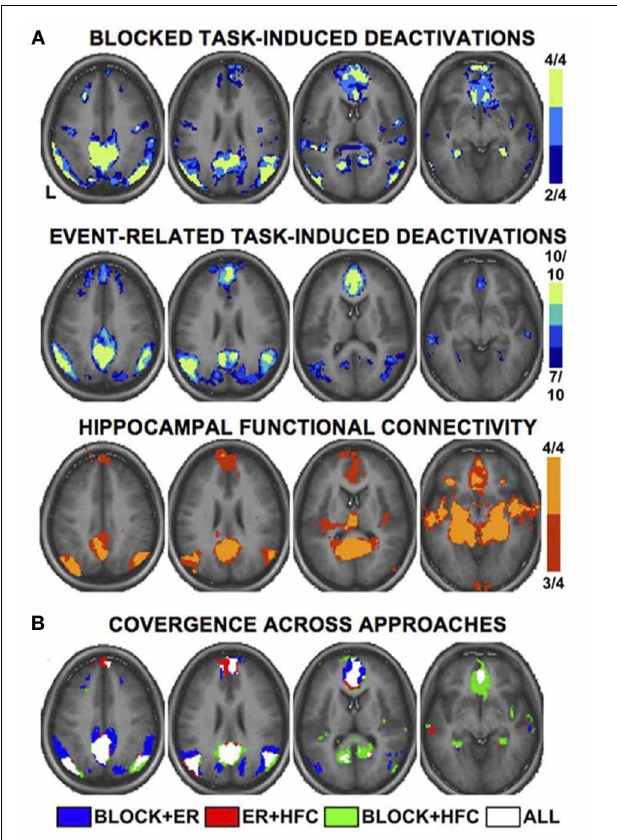
FIGURE 2 | Multiple fMRI methods defining the default mode network. Key cortical areas contributing to the default mode network, as revealed by distinct fMRI methods and study designs. Data are based on a meta-analysis by Buckner et al. (2008) that included 4 blocked design fMRI studies, 10 event-related fMRI studies, and 4 studies of functional connectivity. Colors for each panel of images denote the number of studies finding significant effects at a given voxel (see color bars and numeric labels at right). Note the similarity in the pattern of regions recruited, regardless of method (A) , and the strong convergence across all methods (B) . Reproduced with permission from Buckner et al. (2008); originally adapted from Shannon (2006). ER, event-related; HFC, hippocampal functional connectivity.